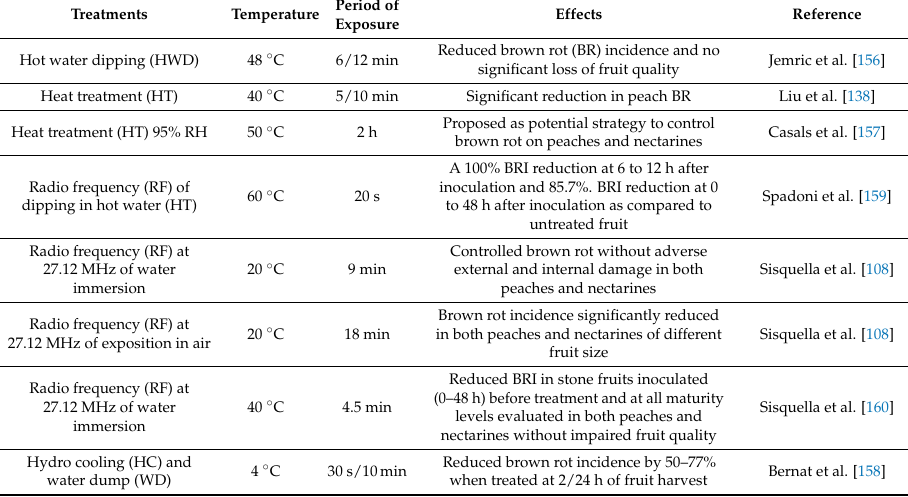
Table 6. Physical treatments to control brown rot in peach: conditions, period, and